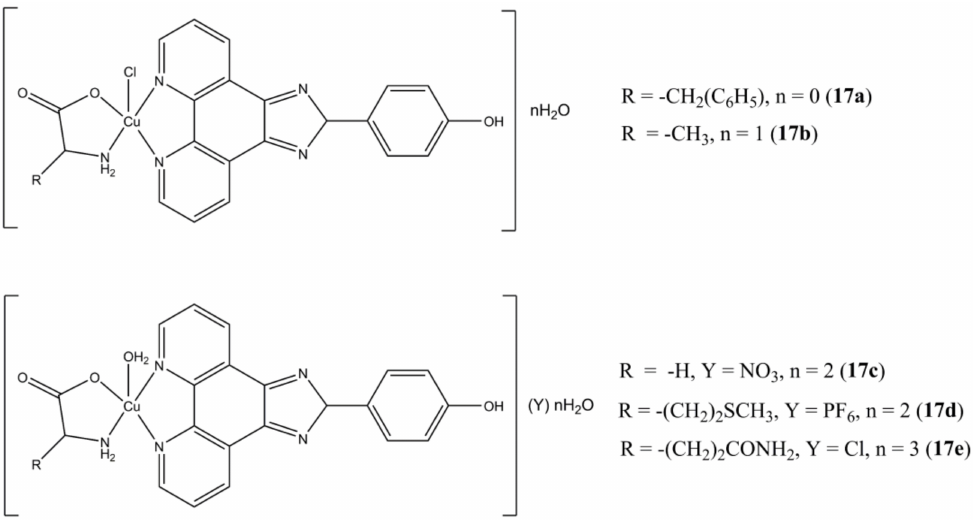
Figure 17. Structures of the Cu(II)–(OH-PIP) based